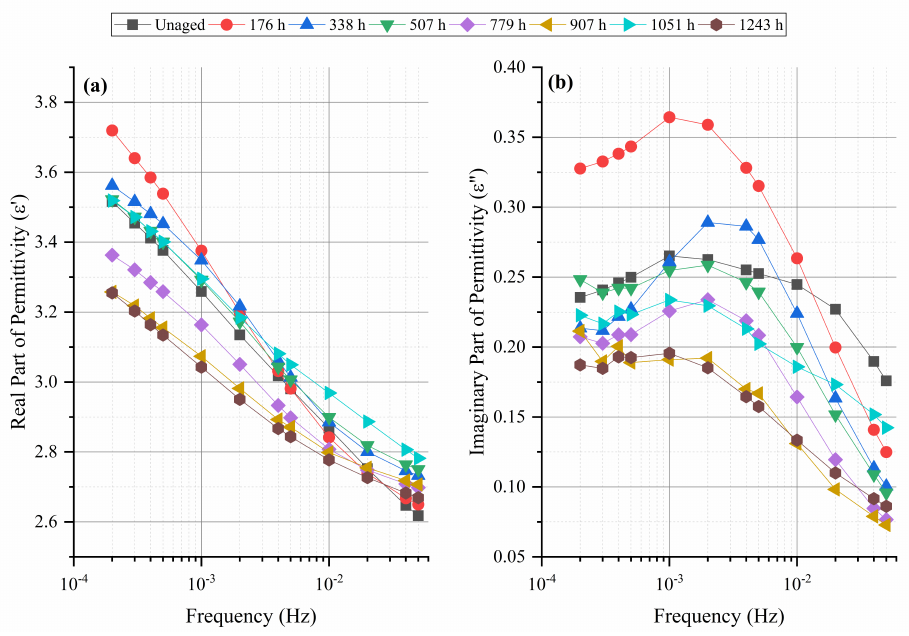
Figure 6. ( a ) Real and ( b ) imaginary parts of permittivities for thermo-mechanical aging. The frequency plot of ε (cid:48)(cid:48) values is shown in Figure 6b. For almost all aging periods, ε (cid:48)(cid:48) started with a particular value. Then, the imaginary part of permittivity increased with frequency, reached a peak value at a specific frequency, and then declined with a further frequency increase. A noticeable increase in the values was noted in the ε (cid:48)(cid:48) after the first T-M period between 2 10 − 4 Hz and 1 10 − 3 Hz, while at higher frequencies, the values × × decreased. After a longer aging time, the ε (cid:48)(cid:48) decreased at all frequencies till the fifth T-M period (907 h). Like the ε (cid:48) , after 1051 h, the ε (cid:48)(cid:48) increased, which then decreased after the last aging